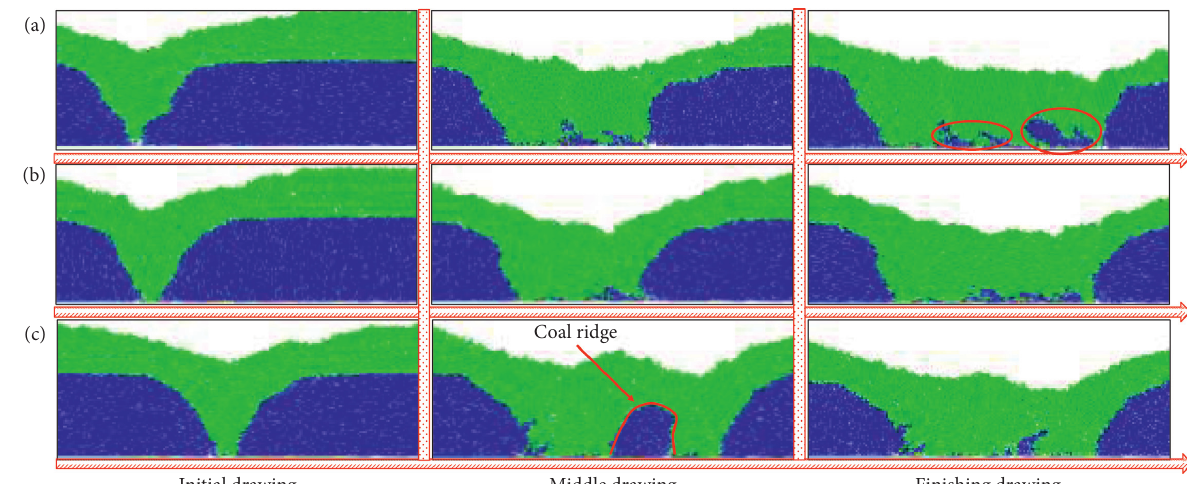
Figure 8: Top coal boundary under three caving technologies: (a) SOSCT; (b) MOSCT; (c) ICGCT.